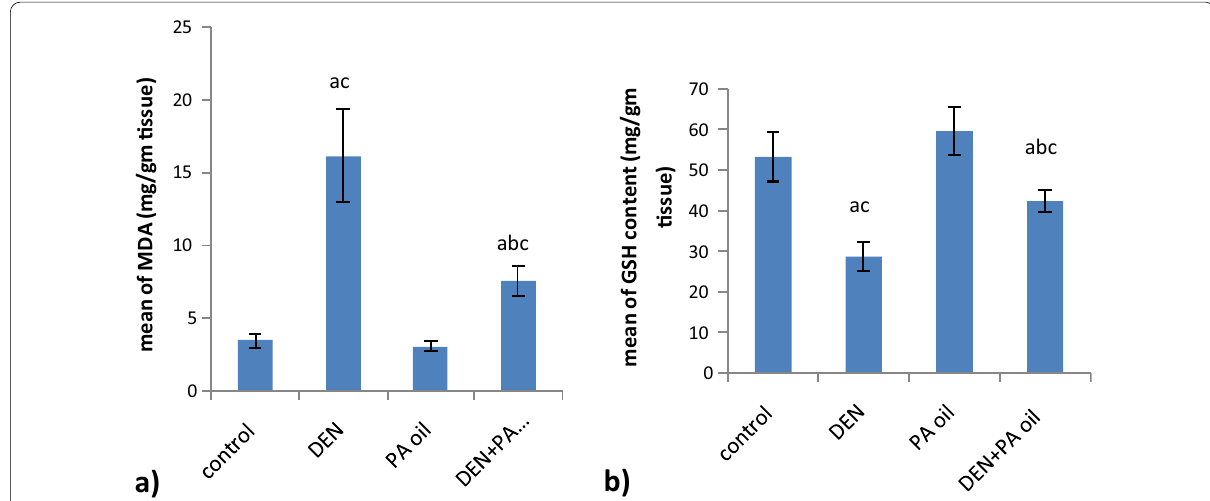
Fig. 1 a , b Effect of PA oil on liver tissue MDA and GSH content in hepatotoxicity induced in rats. Values are expressed as mean a Significant to normal control group ( P =